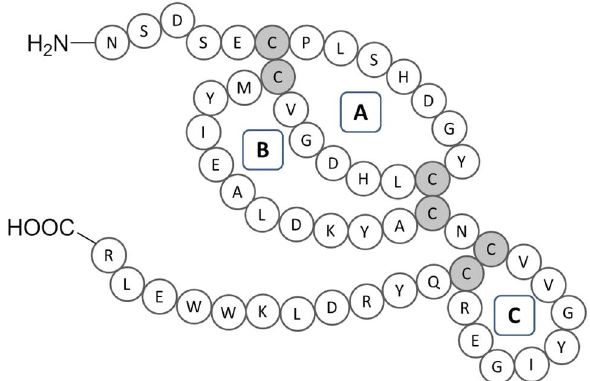
Figure 1. Amino acid sequence of human epidermal growth